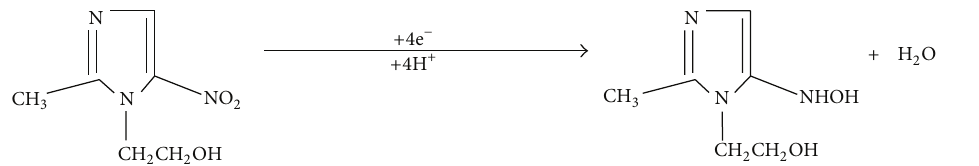
Scheme 1: The proposed reaction mechanism of metronidazole at CPE.